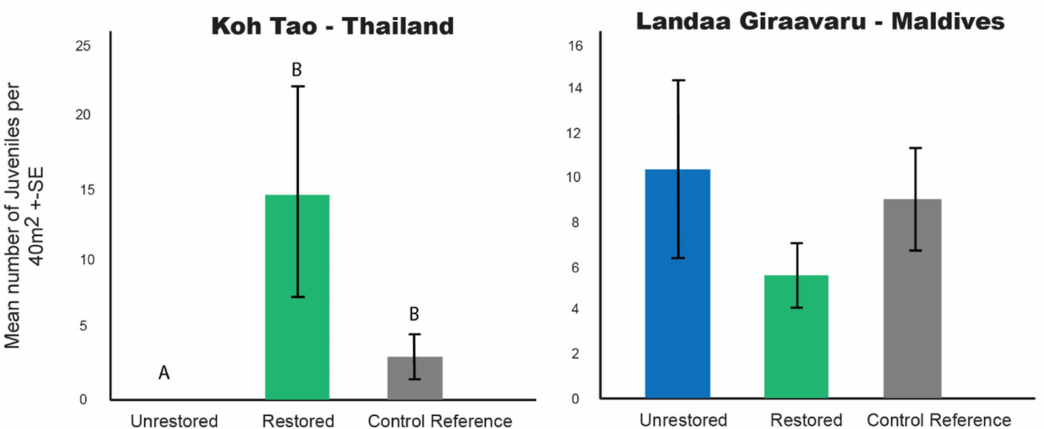
Figure 5. Mean number of juvenile corals counted per 40-m 2 belt transect ( ± SE) compared among treatments (unrestored, restored, control reference sites) in Koh Tao (Thailand) and Landaa Giraavaru (Maldives). Letters above each histogram indicate whether mean values di ff er significantly (di ff erent letters) or are statistically indistinguishable (same letters). n = 9 transects per treatment.